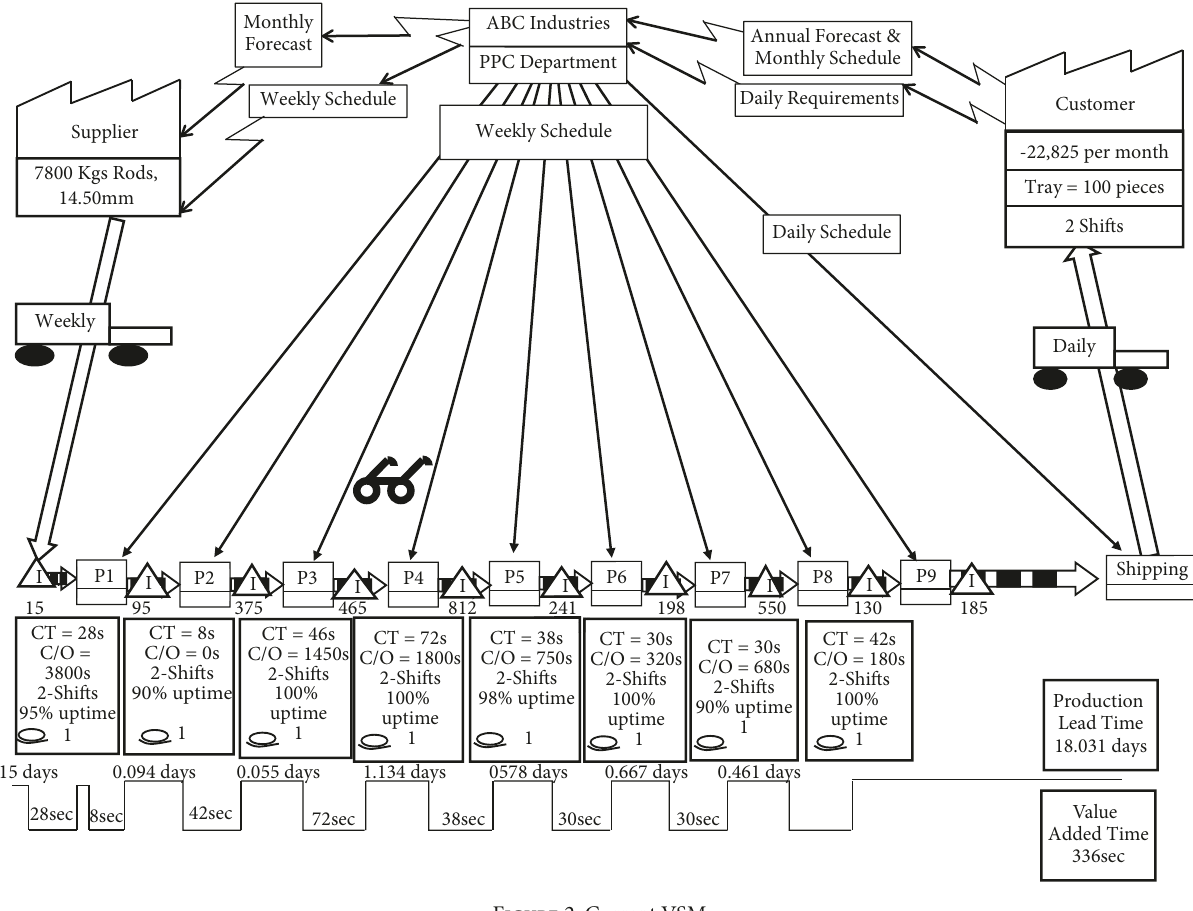
Figure 2: Current